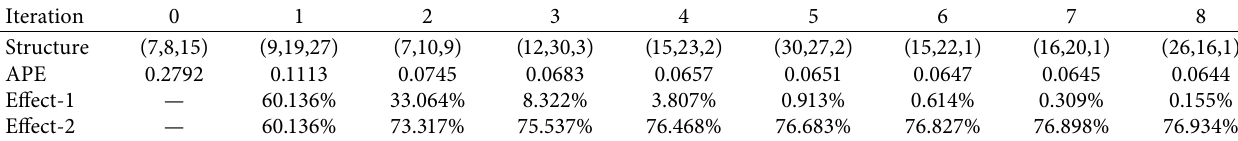
Table 1: MA Iteration results on RMSA.